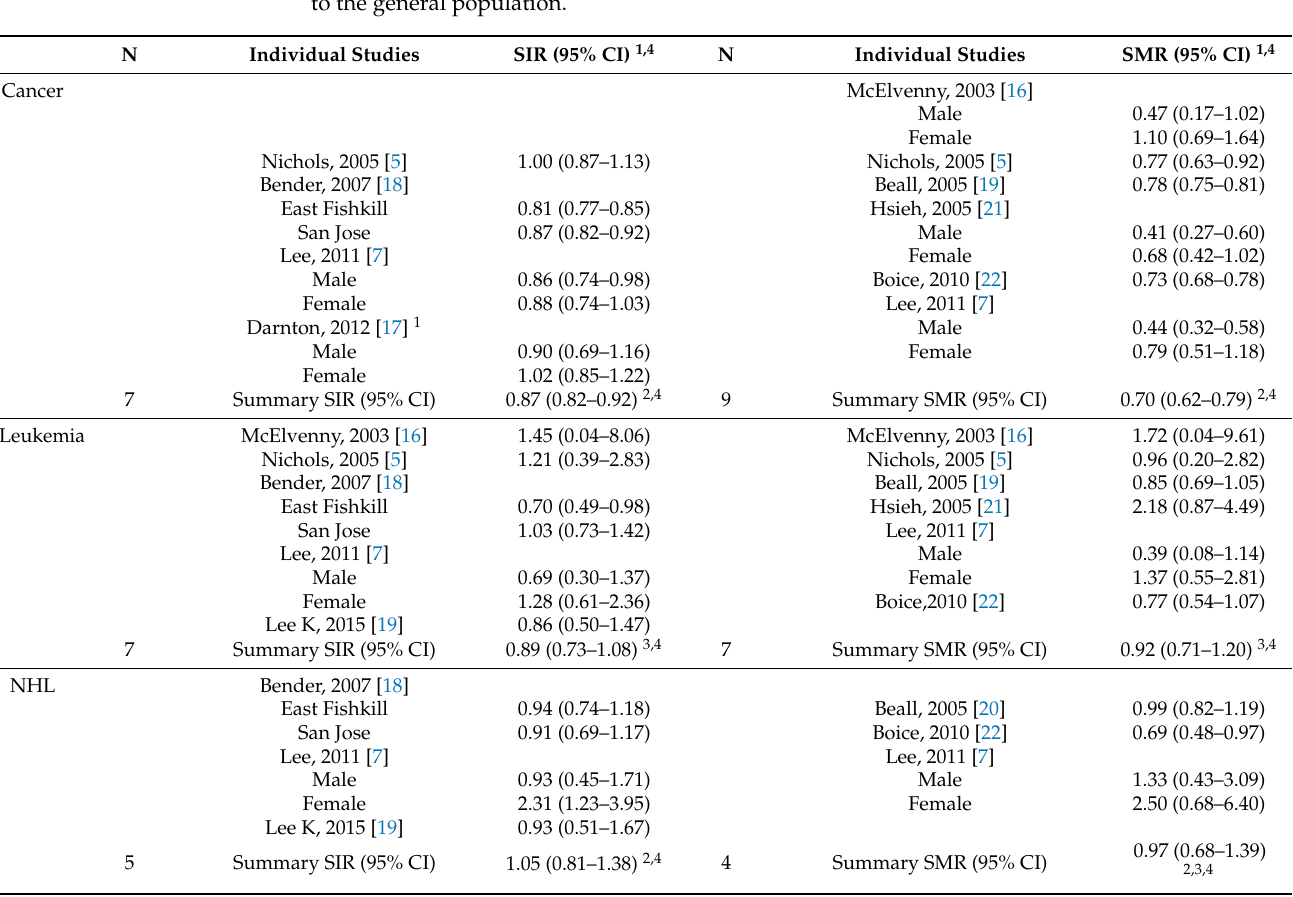
Table 2. Meta-analysis for the standardized incidence ratios (SIRs) and standardized mortality ratios (SMRs) of cancer, leukemia, NHL, brain tumor, and breast cancer in semiconductor workers compared to the general